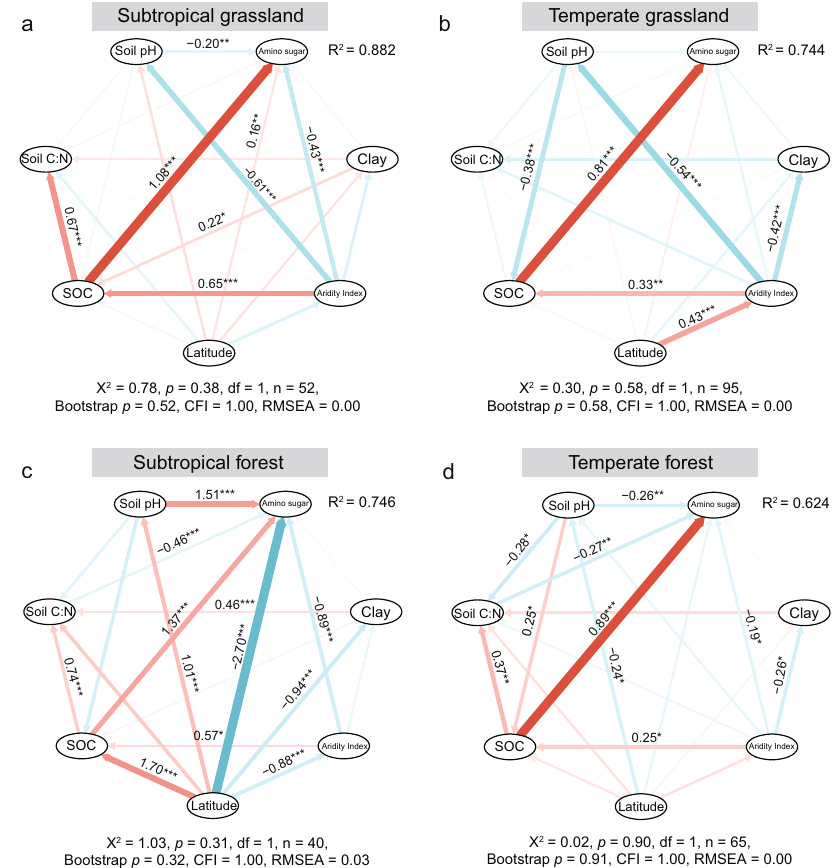
Fig. 6 Structural equation models (SEMs) for ecosystems and climatic zones. a Subtropical grassland. b Temperate grassland. c Subtropical forest. d Temperate forest. The SEMs show the causality and correlation between the absolute content of soil amino sugars (characterization of microbial residues) and environmental variables. Red lines indicate positive effects, while blue lines indicate negative effects. The thickness and color of the line are directly proportional to the standardized path coef fi cient on the single arrow. SOC soil organic carbon. R 2 represents the variance of biomarkers explained by the model. The asterisk (*) indicates the signi fi cance of the path; one, two, and three asterisks indicate p < 0.05, p < 0.01, and p < 0.001,